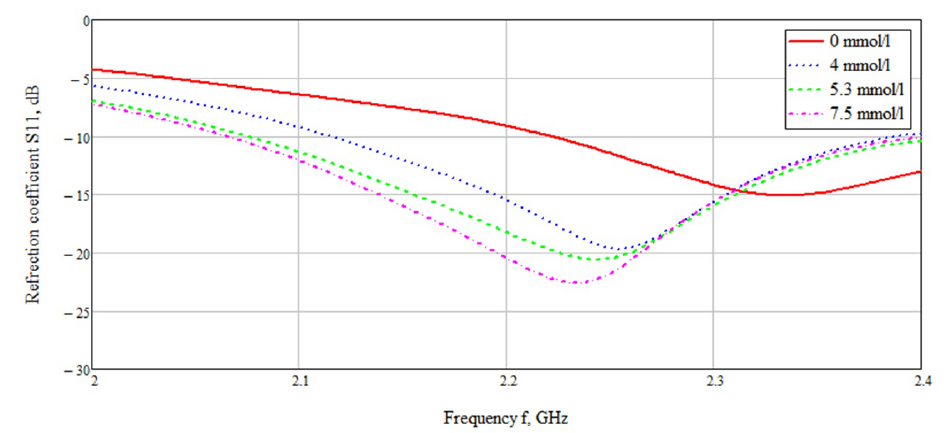
Figure 14. Frequency dependence of the reflected signal from the unidirectional probe for various glucose concentrations. Frequency range 2–2.4 GHz.